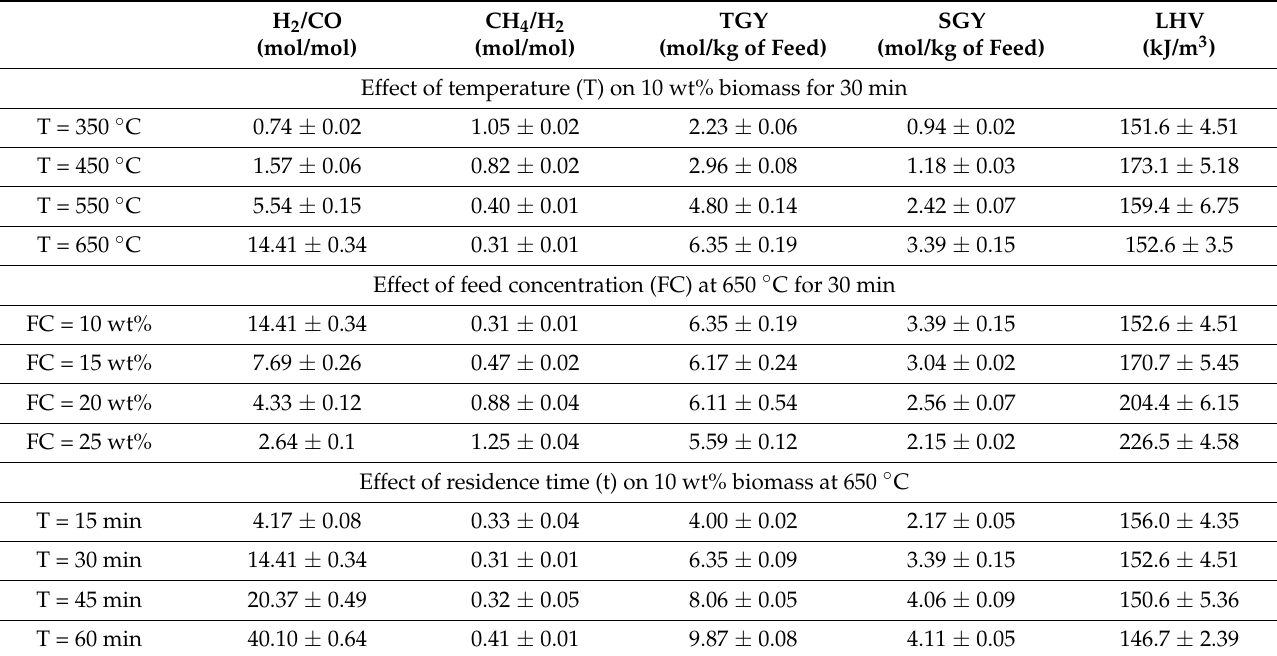
Table 1. Influence of process conditions on the gas yields and quality obtained from SCWG of canola hull